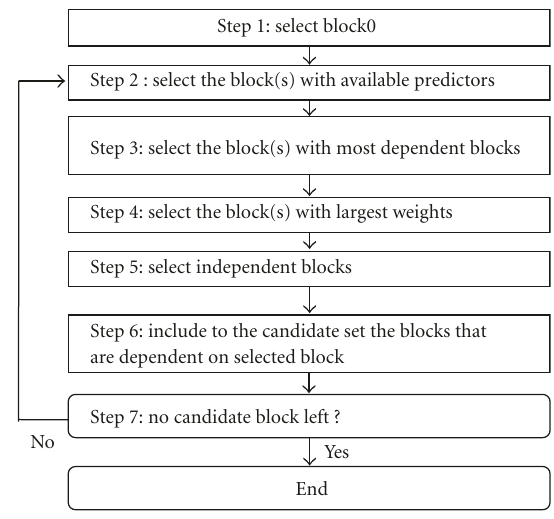
Figure 6: Processing order selection algorithm.